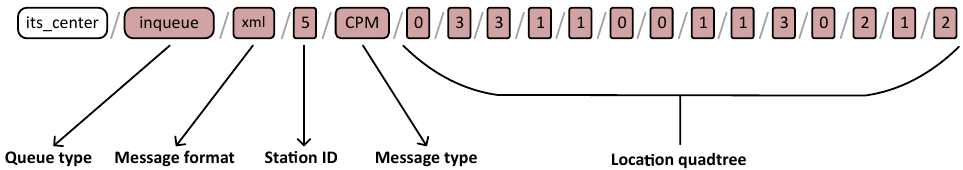
Figure 5. MQTT quadtree-based topic structure (tiling